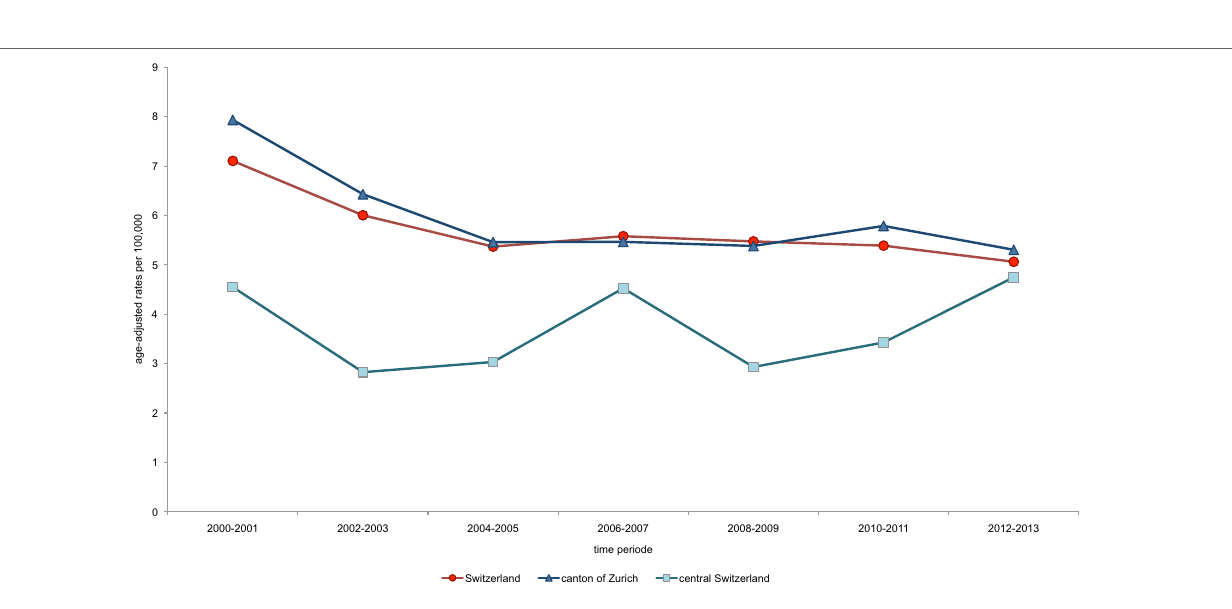
FigUre 5 | Trends in age-standardized incidence rates (ASIR) of cervical cancer (CC) in Switzerland, the Canton of Zurich and Central Switzerland. There are similar trends in ASIR of CC in Switzerland and in the Canton of Zurich over the course of the observed time. CC incidence in Central Switzerland was lower in earlier years, but all rates converged in 2012/2013 (Central Switzerland: 4.8/100,000, Switzerland: 5.1/100,000, and Canton of Zurich: